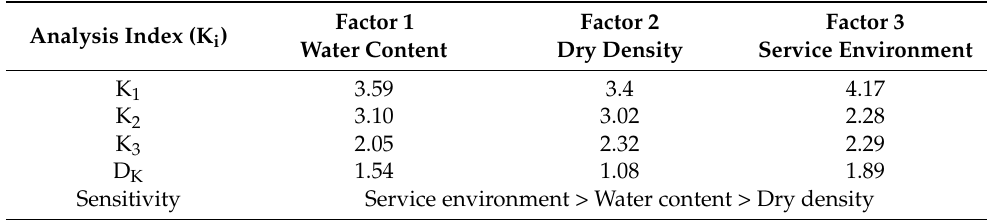
Table 8. Analysis of range